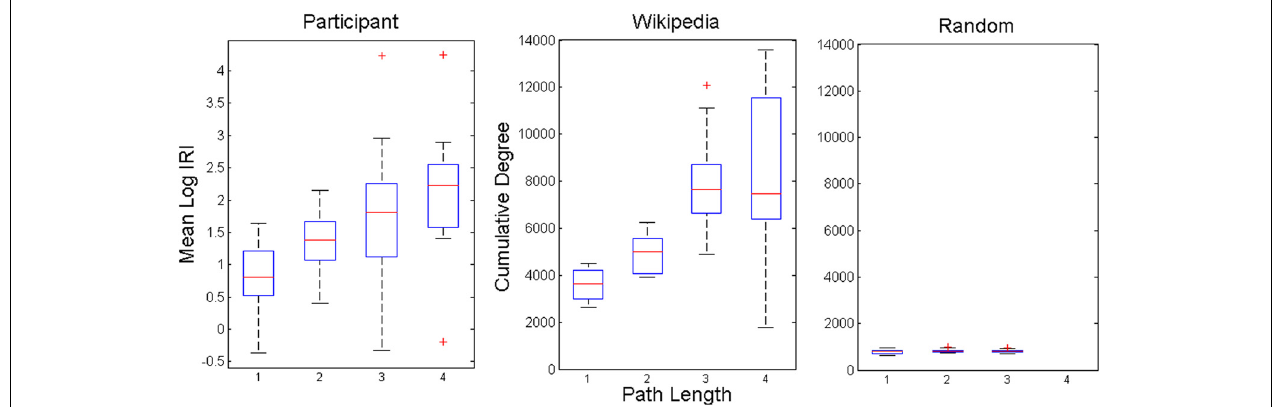
FIGURE 6 | Averaged response time measures between items with intervening network path lengths of 1–4. Box plots show median and quartile values with outlying values (past 1.5 IQR) represented as